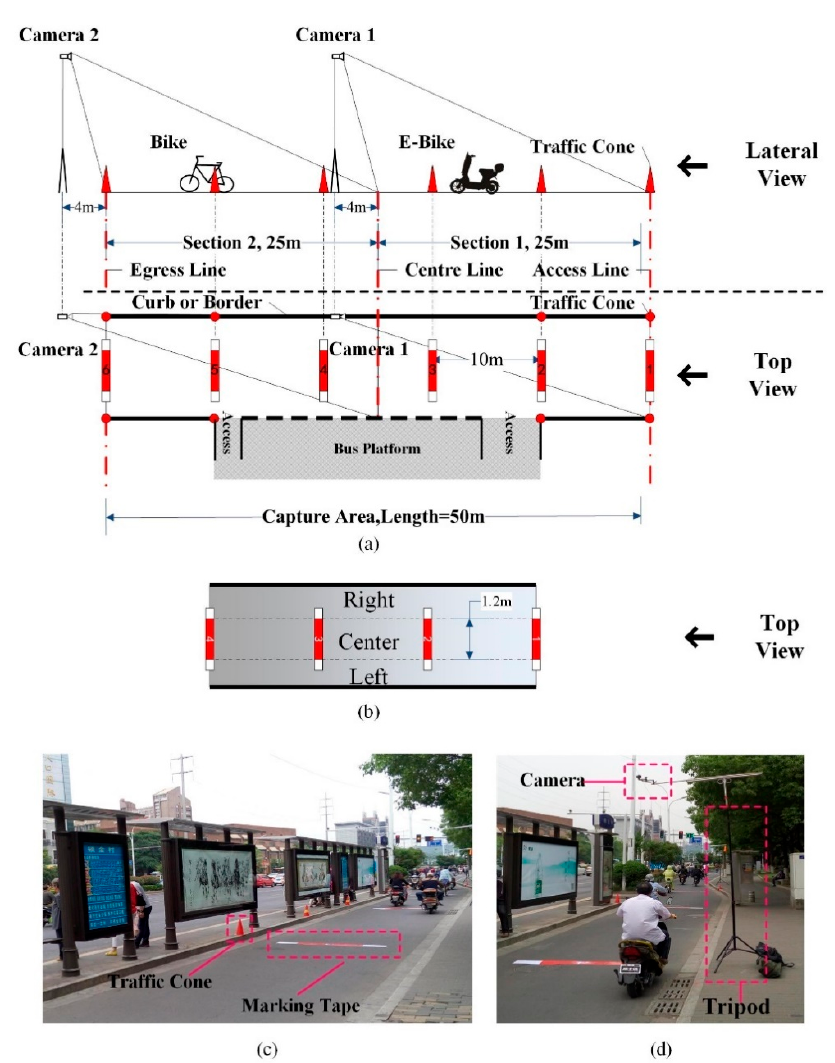
Figure 3. ( a ) Setting details for field observation; ( b ) track surface markings; ( c ) installation of traffic cones and marking tapes; and ( d ) setup of the camera and tripod in field.